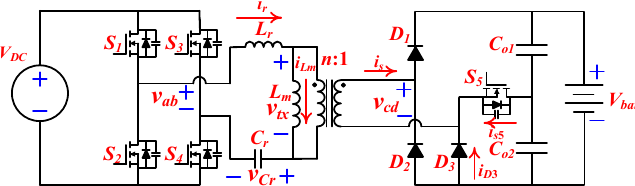
Figure 2. Proposed Pulse-width modulation (PWM)-LLC Topology with reconfigurable structure.